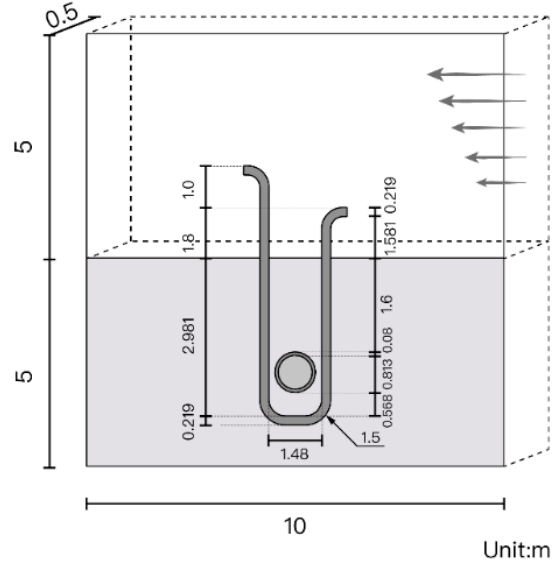
Figure 8. Geometric model used in the numerical calculations.